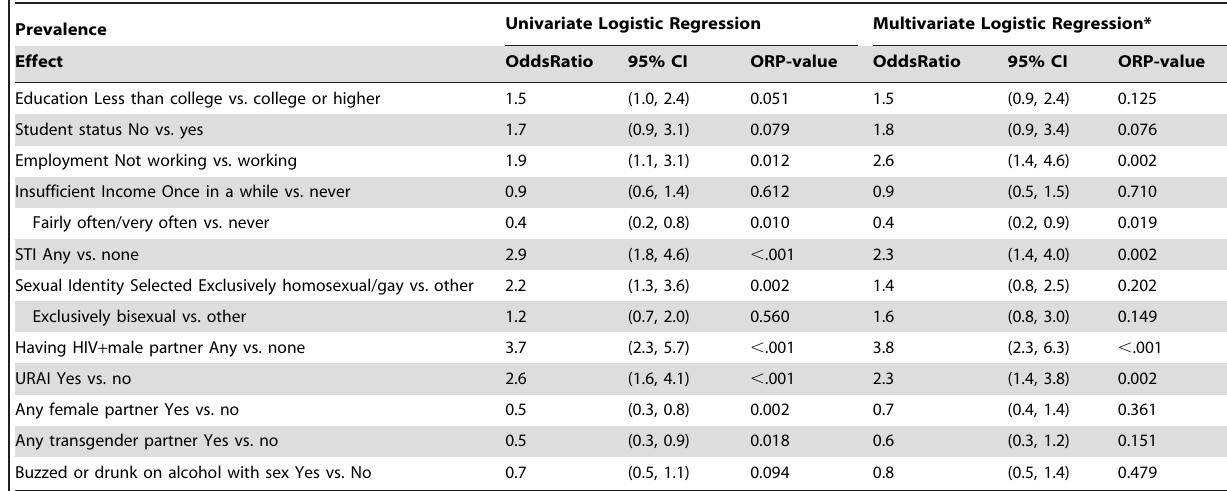
Table 6. Univariate and multivariate logistic regression on modeling the probability of Black men who have sex with men being newly diagnosed HIV infection (NHIV) versus HIV-uninfected at time of